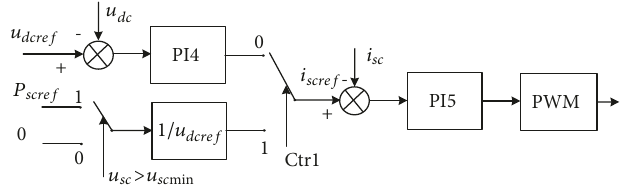
Figure 4: Control block diagram of SCESU.